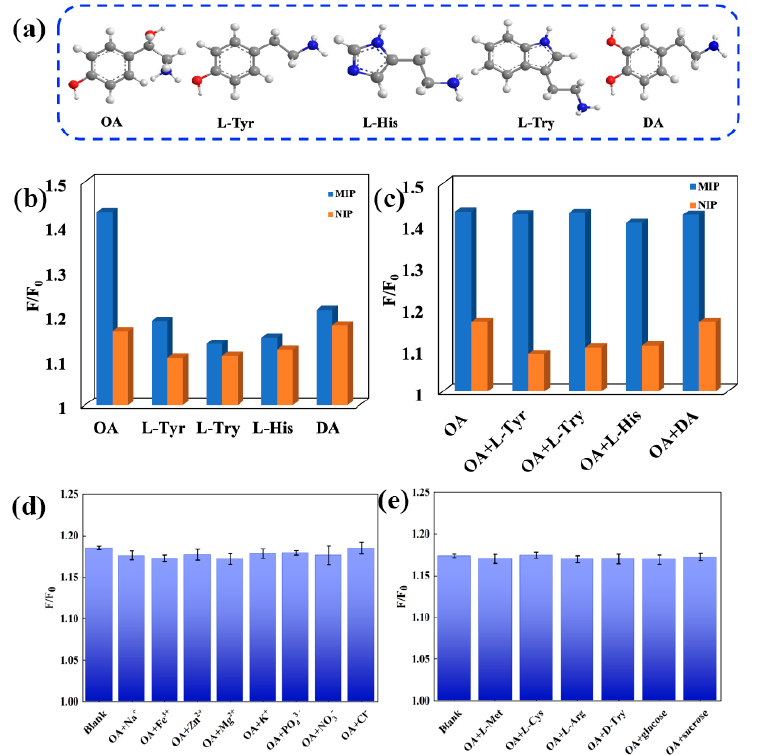
Figure 5. ( a ) The structure of OA, L-Try, L-Tyr, L-His, and DA. ( b ) Changes in the